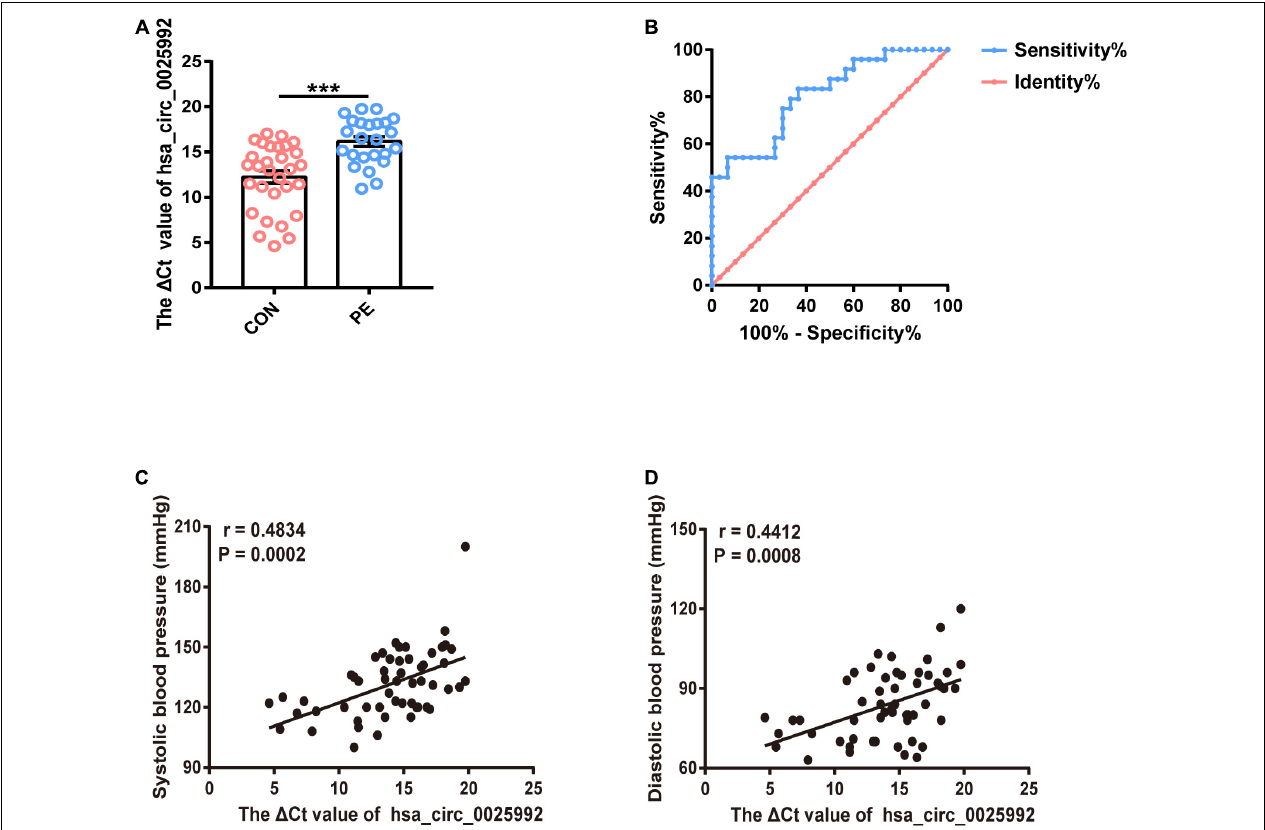
FIGURE 7 | Hsa_circ_0025992 serving as a potential novel blood biomarker for the prediction of early PE. Expression of hsa_circ_0025992 in blood samples from PE patients ( n = 24) and normal pregnant women ( n = 30) (A) . Data were shown as the mean ± SEM. The ROC curve of hsa_circ_0025992 as a predictive biomarker for early PE. AUC = 0.8065 (95% CI 0.6902–0.9210, P = 0.0001); sensitivity and specificity, 54.17 and 93.33%, respectively. The cutoff value was 16.36 ( (cid:49) Ct value) [the optimal cutoff point was determined at the maximum Youden Index (YI)]. The NPV of a (cid:49) Ct value ≤ 16.36 for a diagnosis of preeclampsia was 71.8%. A (cid:49) Ct value above 16.36 had a PPV of 86.7% (B) . Spearman correlation analysis for hsa_circ_0025992 ( (cid:49) Ct value) in blood samples with the systolic blood pressure and diastolic blood pressure of the corresponding participants (C,D) . * P < 0.05, ** P < 0.01, *** P <